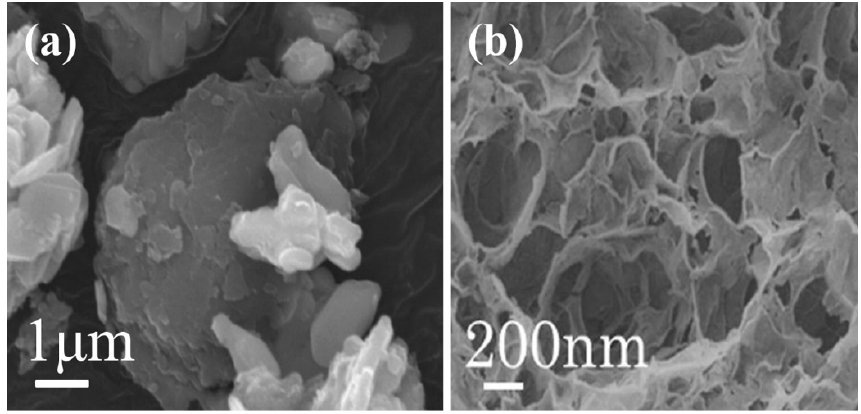
Figure 9. ( a ) SEM image of 0.5CCM3, ( b ) high-magnification FESEM image of GA-CQDs/CNN-24% (reproduced with permission from [100,110]. Copyright Elsevier, 2018; Elsevier, 2018; respectively).